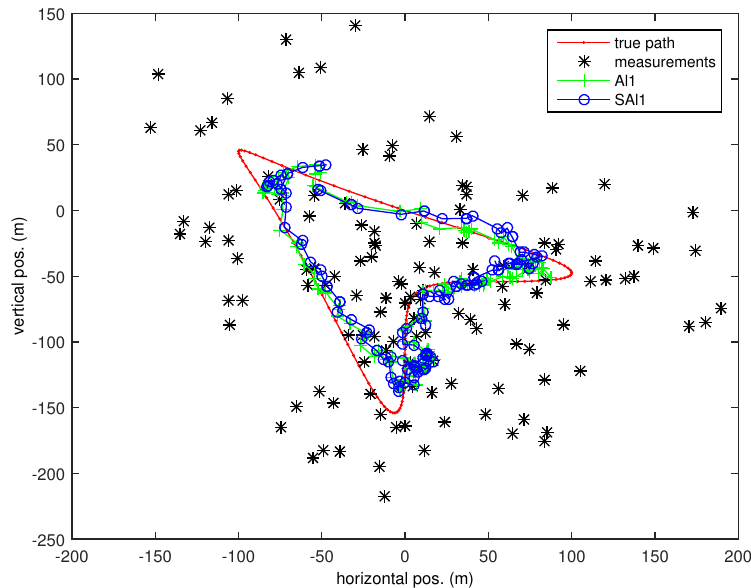
Figure 7. Arrowhead Path with random walk tracker.